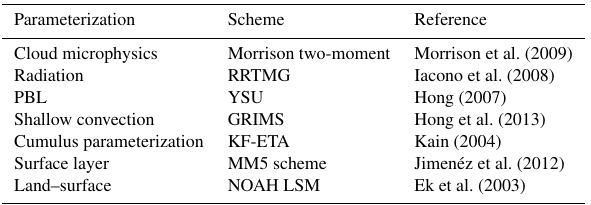
Table 1. Physics parameterizations used in the WRF